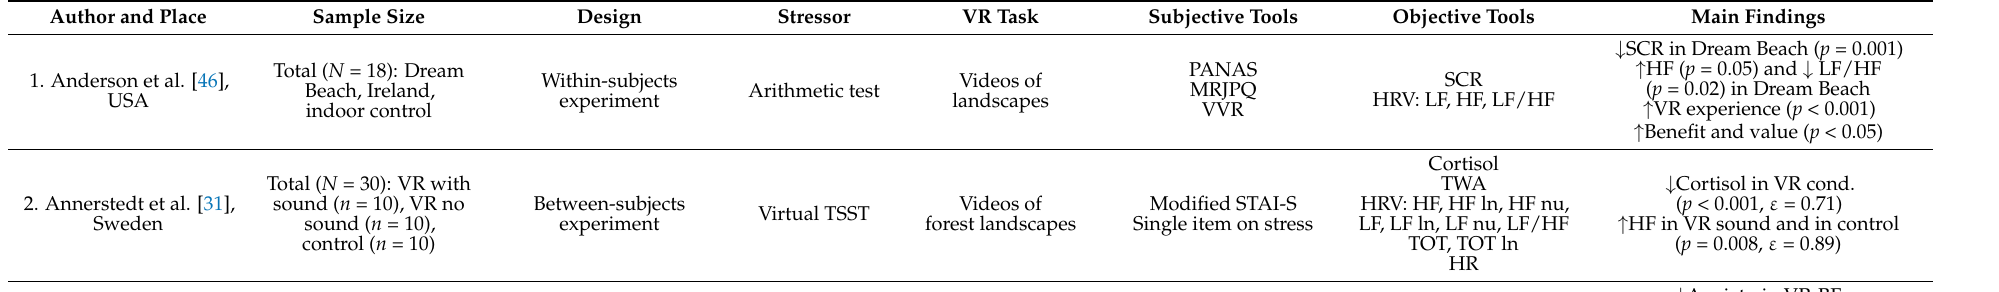
Table 1. Summary of articles included in the current literature